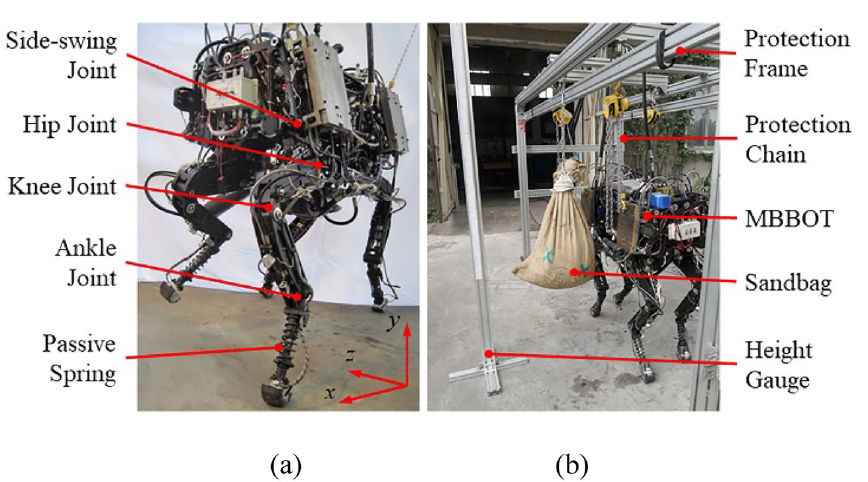
Figure 18. Simulation results of the comparison for different models. ( a ) Body CoM trajectory. ( b ) Lateral velocity.